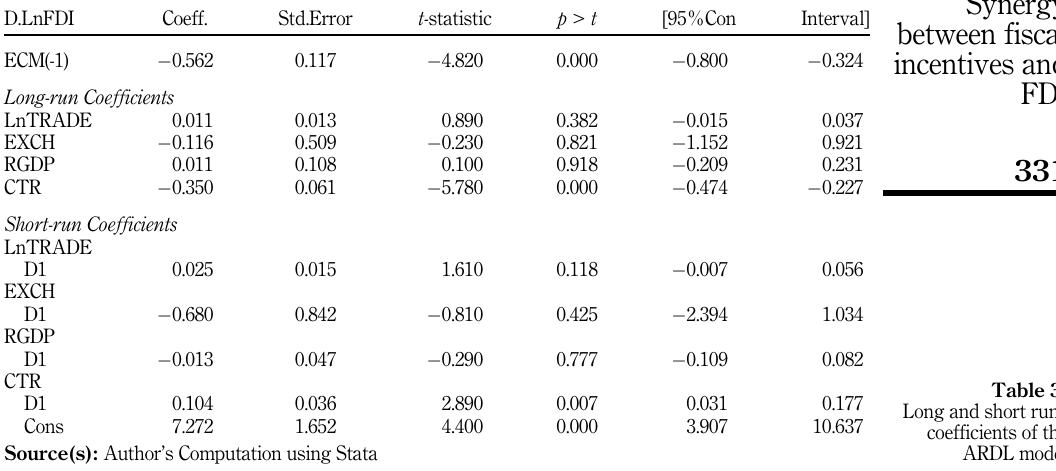
Table 3. Long and short